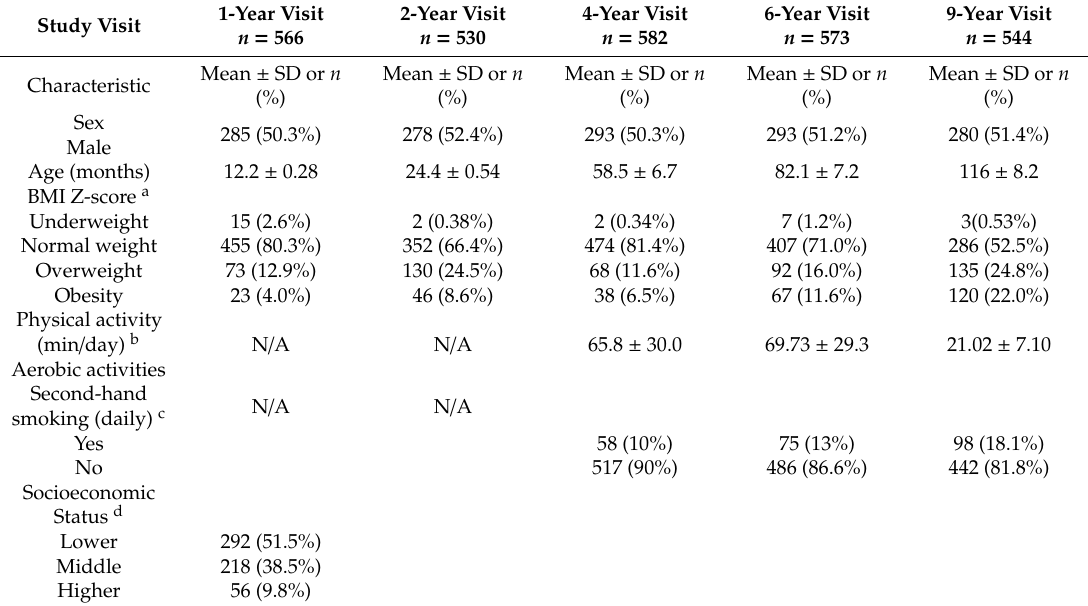
Table 1. Participant characteristics at follow-up study visits.